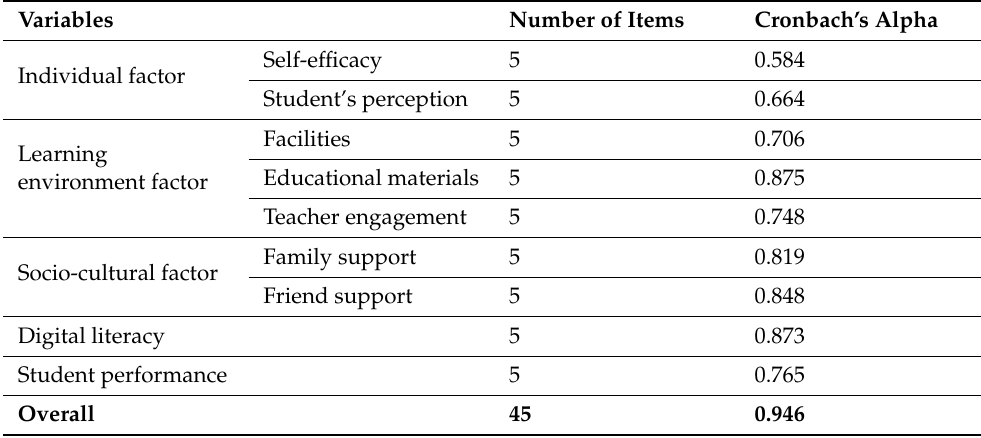
Table 2. Cronbach’s Alpha Analysis